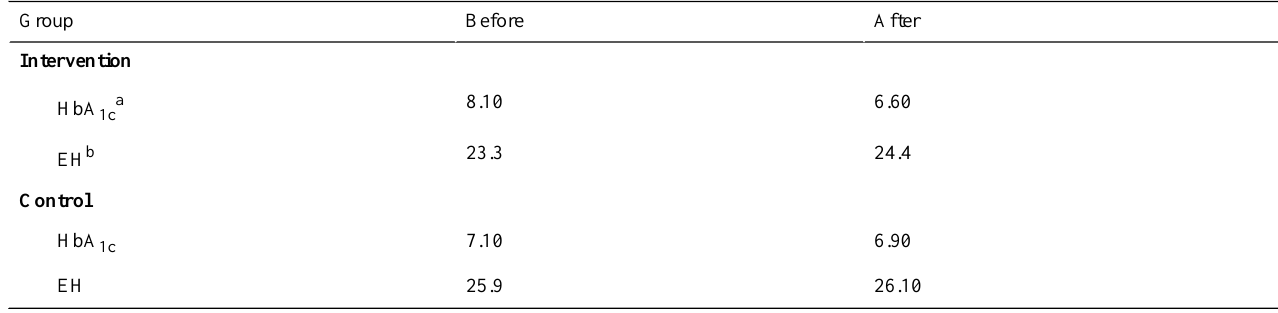
Table 4. Changes in both eating habits composite score and glycated hemoglobin.